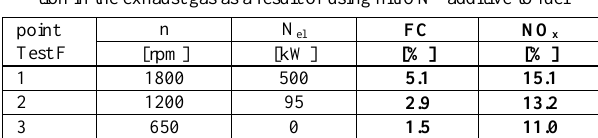
Table 4. Percentage reduction of fuel consumption FC and NO x concentra- tion in the exhaust gas as a result of using nitrON ® additive to fuel